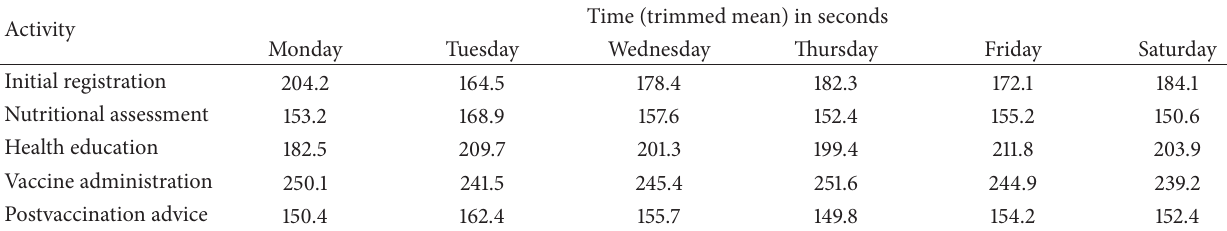
Table 3: Service delivery time (trimmed mean) in relation to day of visit.